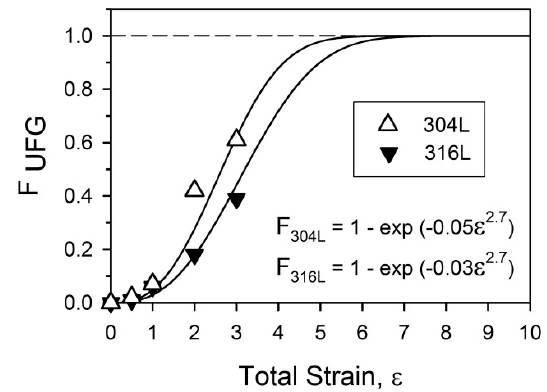
Figure 12. The effect of rolling at 473 K on the fraction of ultrafine grains (F UFG ) in 304L and 316L stainless steels.